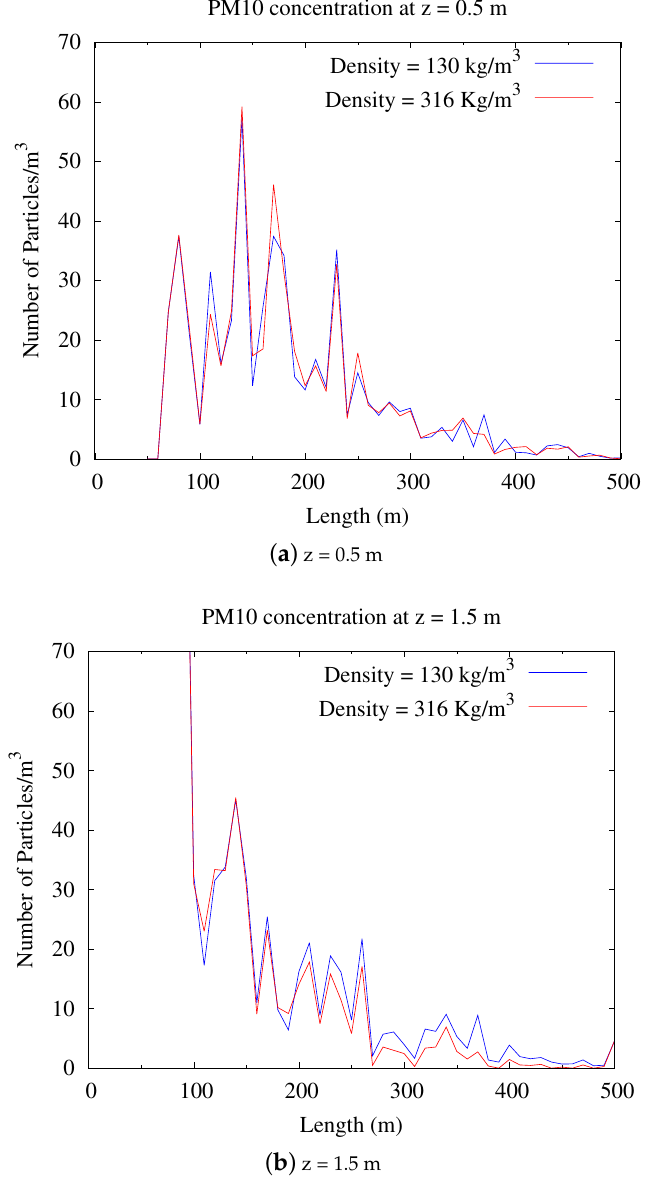
Figure 16. PM10 concentration time averaged over 120 s and spatially averaged over